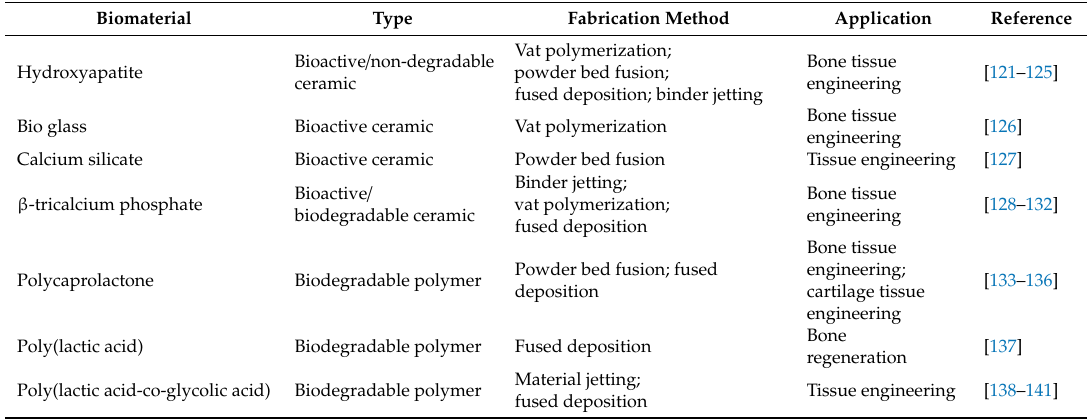
Table 1. Additive manufacturing methods of biomaterials for oral tissue engineering.